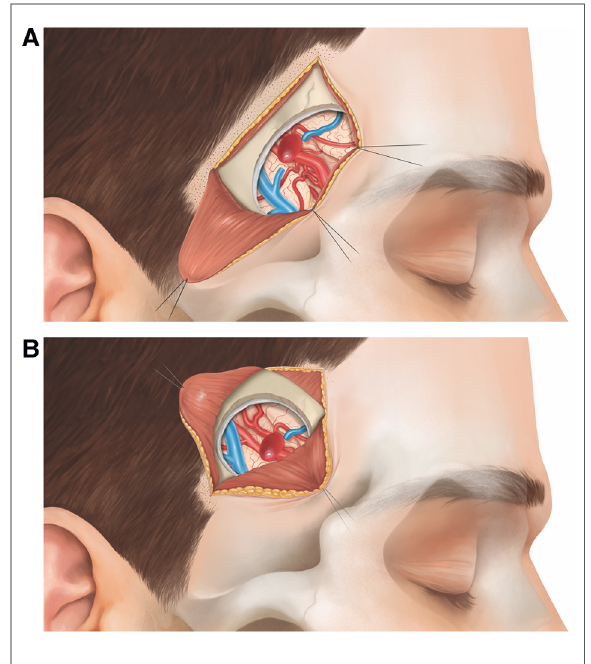
FIGURE 3 Schematic representation of a right-sided MCA bifurcation aneurysm, exposed via ( A ) MPT and ( B )